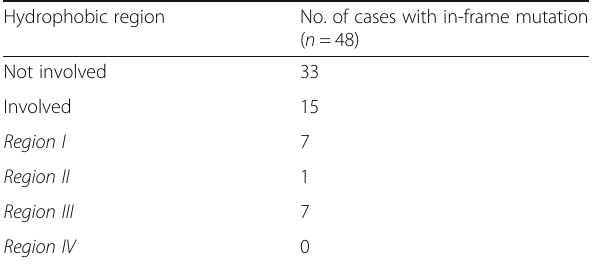
Table 2 Hydrophobic region mutations identified in this cohort by Kyte-Doolittle scale mean hydrophobicity profile analysis using BioEdit software